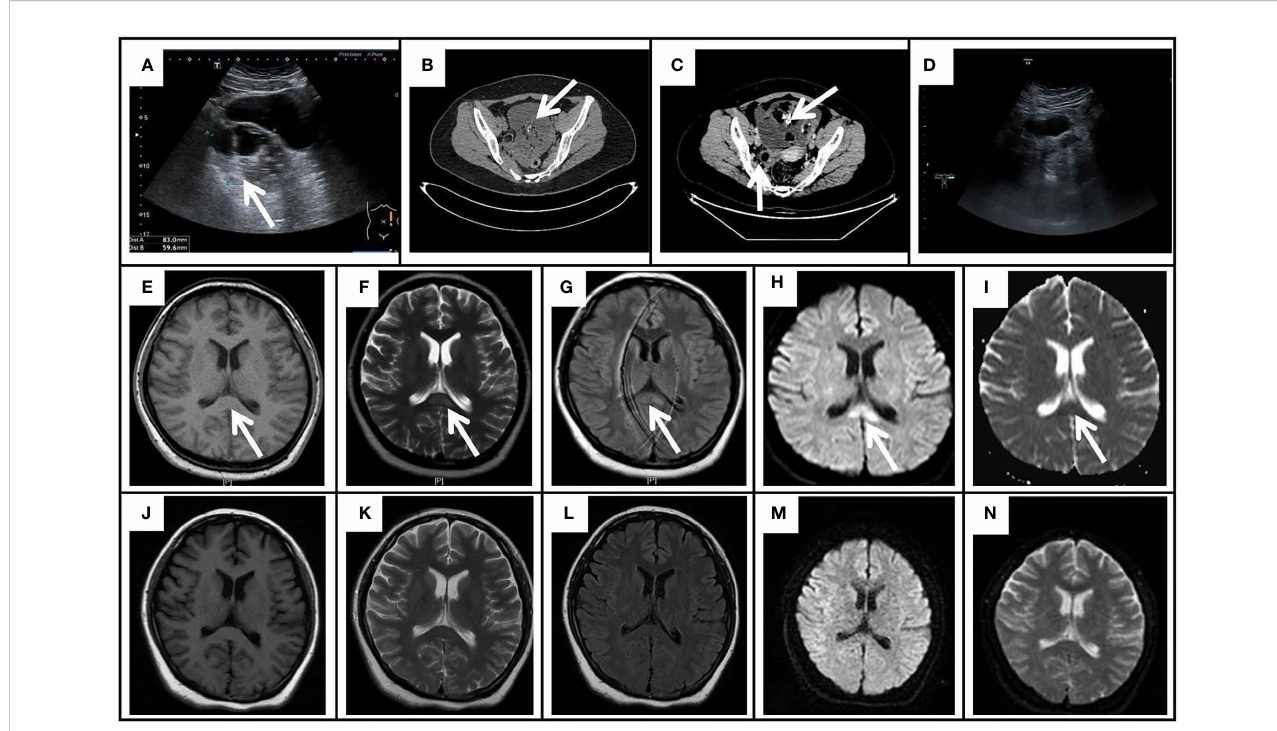
FIGURE 1 The gynecological ultrasound, pelvic CT, and cranial MRI results of the patient. (A) The gynecological ultrasound showed a mixed echogenic mass (8.3 cm × 5.9 cm) in the left ovary. (B) Pelvic CT showed an irregular cystic mass (10.2 cm × 8.4 cm) with a few calci fi cations and fatty components in the posterior aspect of the bladder. (C) Enhanced CT of the pelvis revealed a large cystic-solid mass in the anterior aspect of the uterus with no enhancement of the cystic component, fat and calci fi cation, and mild enhancement of the solid component; A mass of uneven density on the right side of the uterus with a predominantly solid component, mild enhancement of the solid component and no enhancement of the fatty component. (D) The repeated gynecological ultrasound demonstrated no abnormal echogenicity. Initial cranial MRI exhibited an isolated splenium of the corpus callosum (SCC) lesion (arrows) with slight hypointensity on T1WI (E) , hyperintensity on T2WI (F) , FLAIR (G) , and DWI (H) , and hypointensity on the ADC map (I) . On day 52 after onset, repeated MRI demonstrated the lesion of SCC lesion was completely resolved on T1WI (J) , T2WI (K) , FLAIR (L) , DWI (M) , and ADC (N)